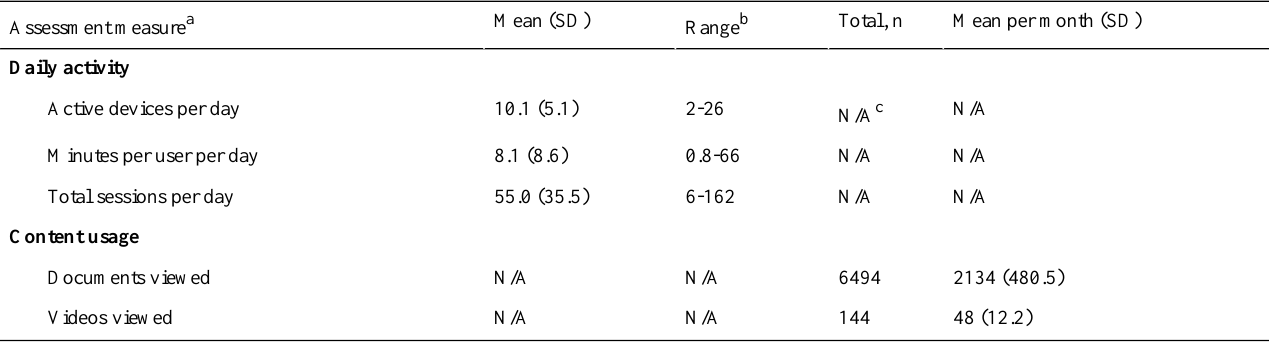
Table 4. Postgraduate assessment of utilization during a trial period among health professionals in the Division of Neurology at the University Hospital of Geneva,